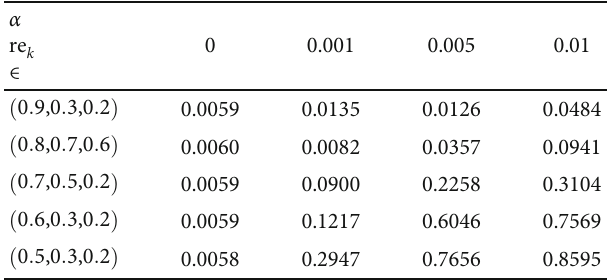
Figure 2: The numerical results for Example 17 for various noise levels with μ = 10 − 5 δ 3/4 and γ = 1/10 . ff erent noise levels ϵ and Table 1: The relative error re k with di fractional orders α for Example